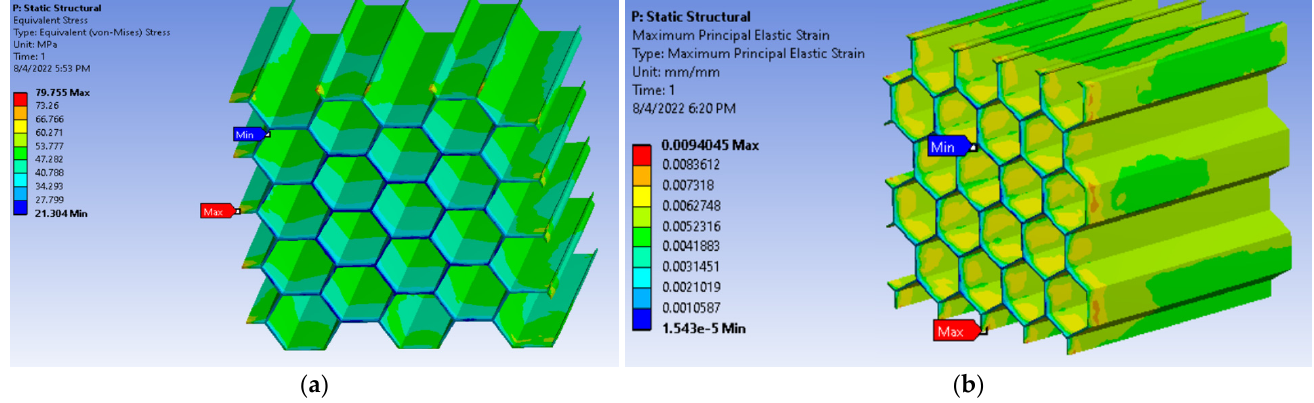
Figure 22. Results determined for the FEA: ( a ) Equivalent stress (von-Mises stress) for the CPE CF112 Carbon; ( b ) Equivalent strain for the CPE CF112 Carbon. Table 11. Comparison between the FEA and experimental results for the CPE CF112 honeycomb. Evaluated